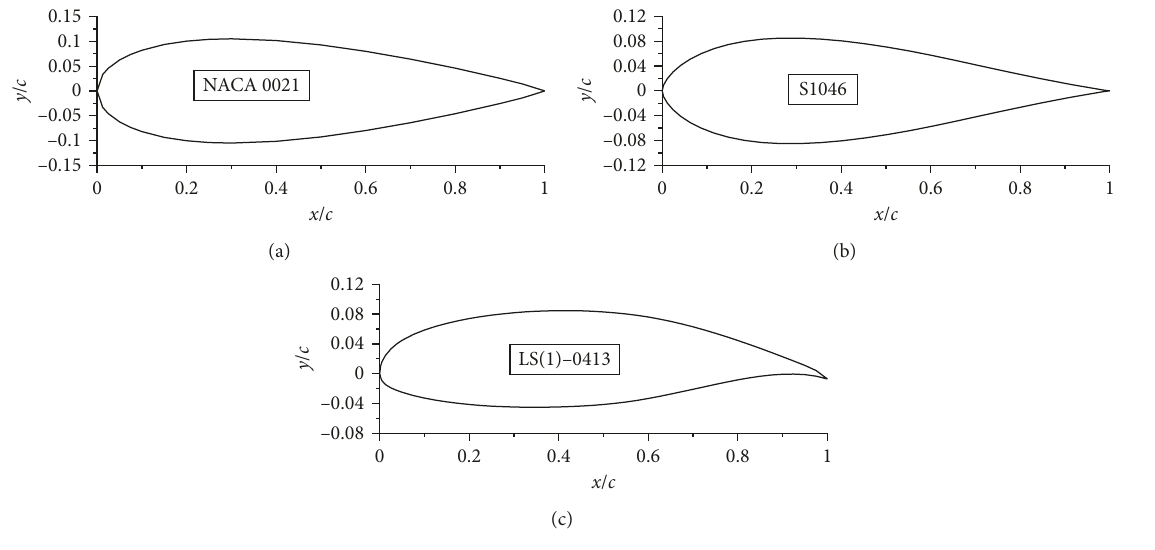
Figure 5: Airfoil shapes. Table 1: Darrieus turbine